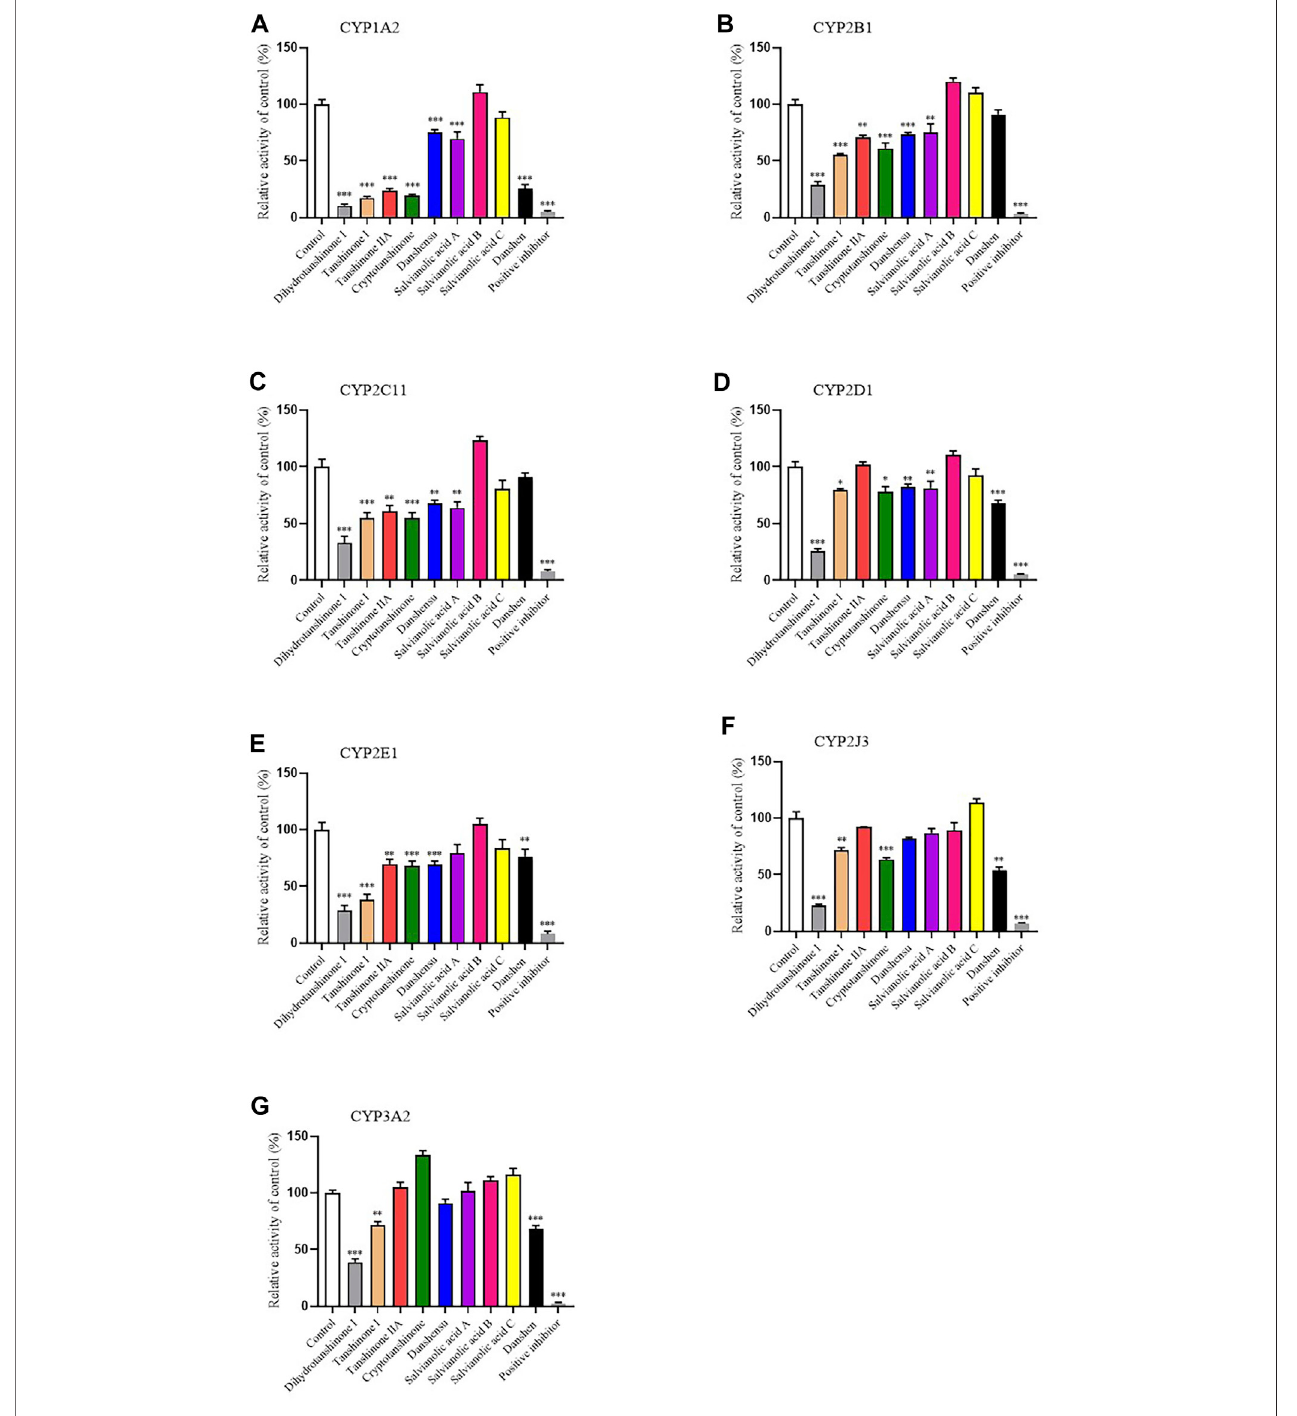
FIGURE 4 | Inhibitory effects of eight active components of Danshen (dihydrotanshinone I, tanshinone I, tanshinone IIA, cryptotanshinone, danshensu, salvianolic acid A, salvianolic acid B, and salvianolic acid C, 20 μ M) and Danshen tablet (2 mg/ml) on activities of CYP1A2 (A) , CYP2B1 (B) , CYP2C11 (C) , CYP2D1 (D) , CYP2E1 (E) ,CYP2J3 (F) ,andCYP3A2 (G) inRLM.Positiveinhibitorsincludedfurafylline(CYP1A2),thiotepa(CYP2B1),sulfaphenazole(CYP2C11),quinidine(CYP2D1), disul fi ram (CYP2E1), fl unarizine (CYP2J3), and ketoconazole (CYP3A2). Values are presented as mean ± SD ( n = 4). * p < 0.05, ** p < 0.01, and *** p < 0.001 compared to control (no